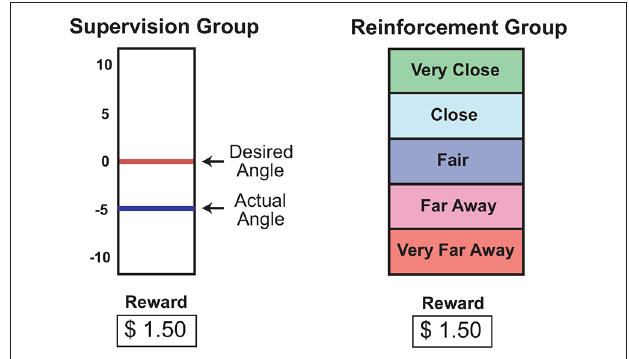
FIGURE 1 | Visual feedback provided to the supervision and reinforcement